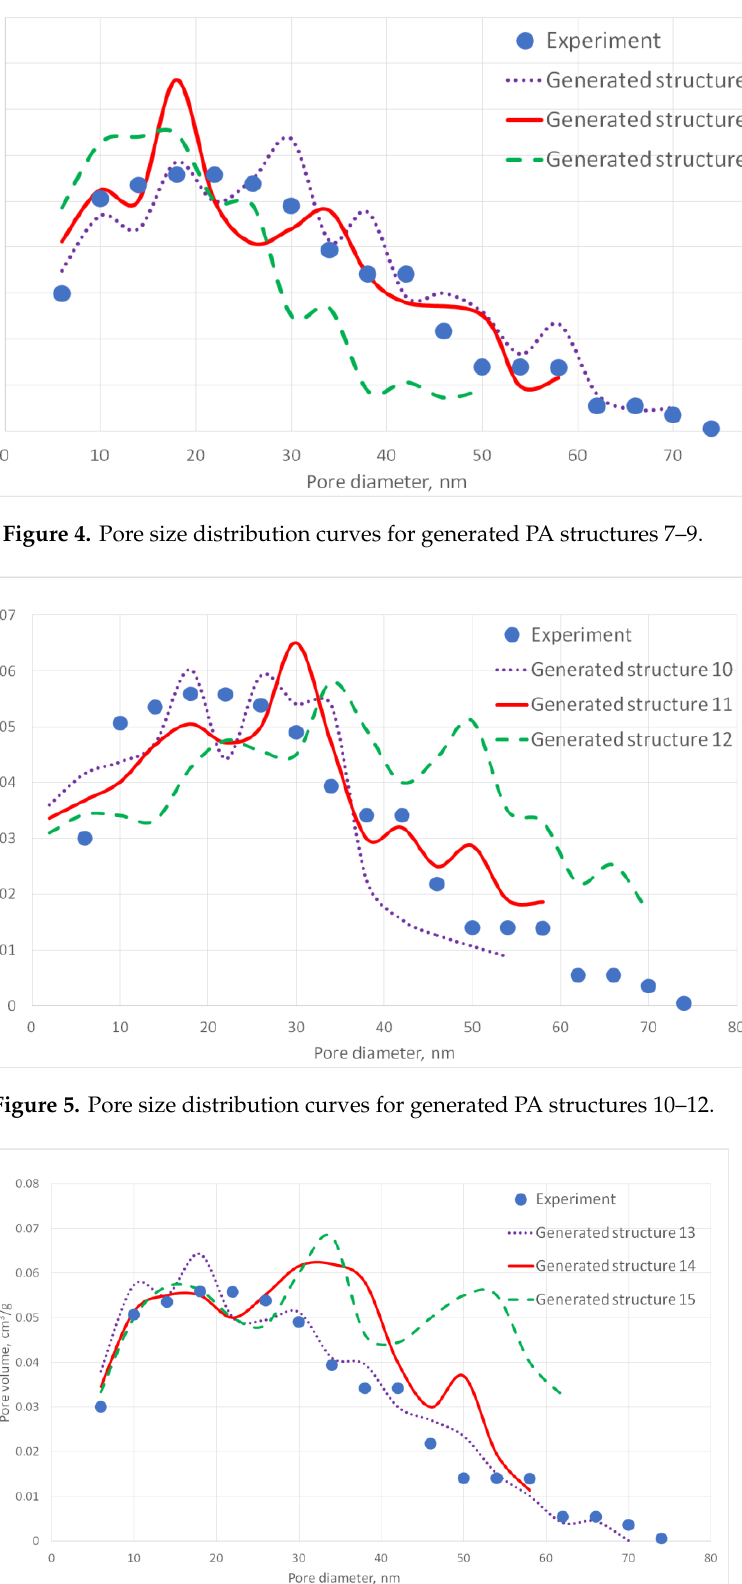
Figure 6. Pore size distribution curves for generated PA structures